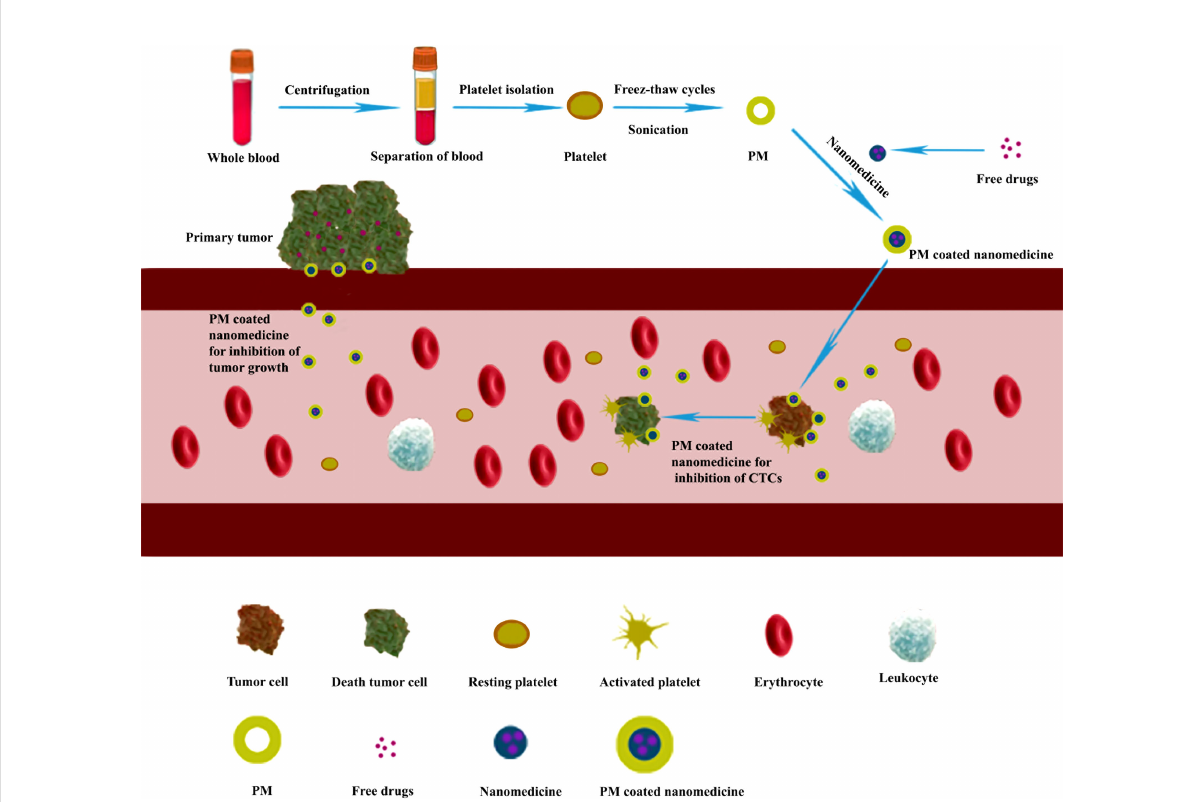
FIGURE 3 Preparation of platelet membrane (PM)-coated nanomedicines used for inhibiting tumor growth and metastasis. The isolated platelets from whole blood were fragmented by freeze – thaw cycles assisted by sonication and puri fi ed by centrifugation to give the desired PM (18). Then the PM fused with nanomedicines to form PM-cloaked nanomedicines for inhibiting tumor growth and